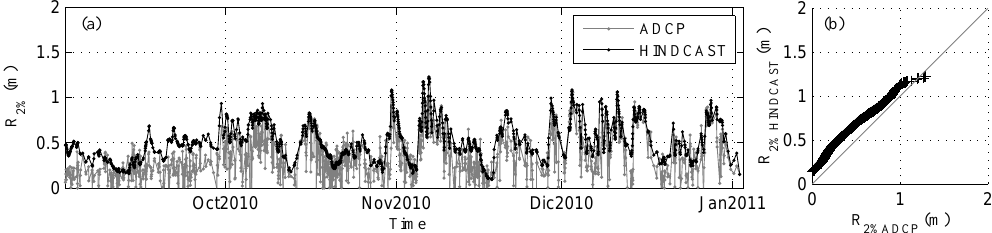
Figure 12. (a) Reconstructed time series of R 2% for a selected period obtained by using measured (ADCP) and hindcasted wave data; (b) Q–Q plot showing the comparison between R 2% obtained using hindcasted and measured wave conditions for the entire 3-year period.